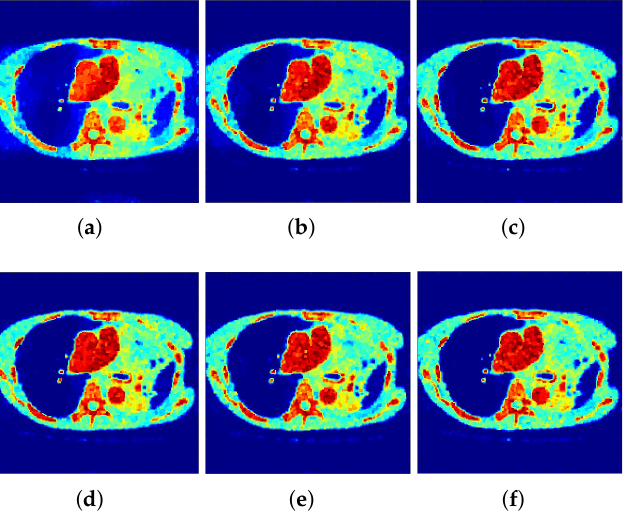
Figure 5. f -MLEM Intermediate MLEM reconstructions. ( a – c ) row: iterations 20, 40, and 60. ( d – f ) row: iterations 80, 100, and 120.